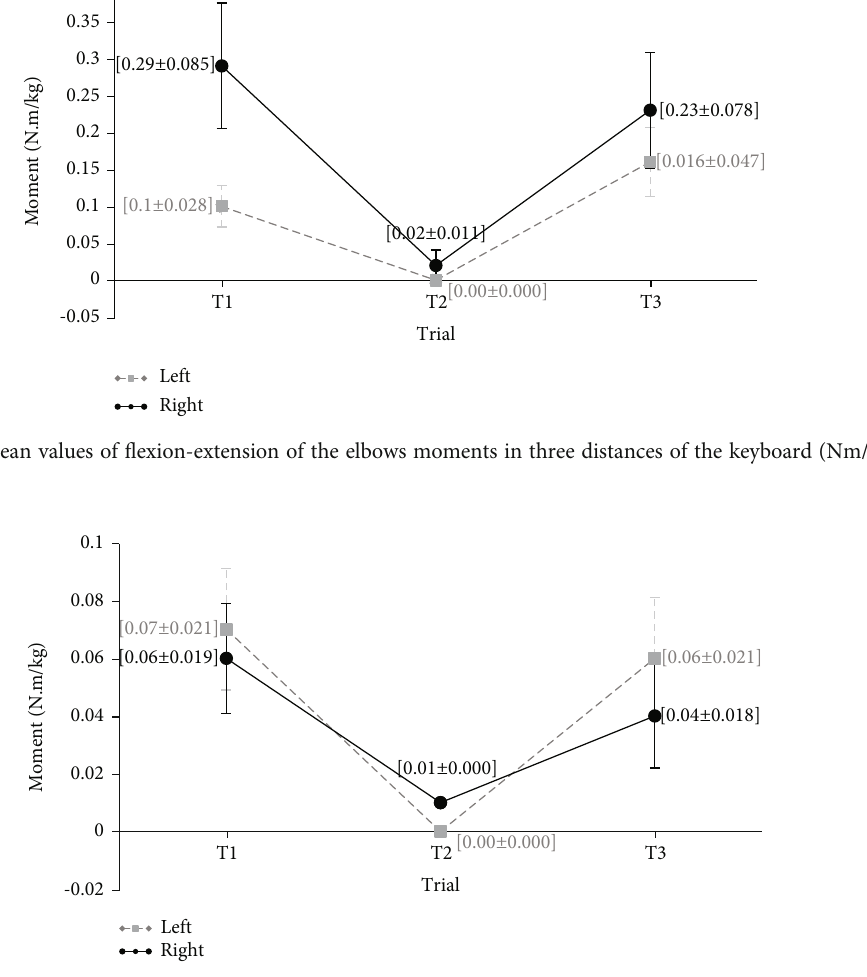
Figure 8: Mean values of supination-pronation of the elbows moments in three distances of the keyboard (Nm/kg). Table 3: Mean (standard deviation) scores of subjective discomfort assessment ( n = 12